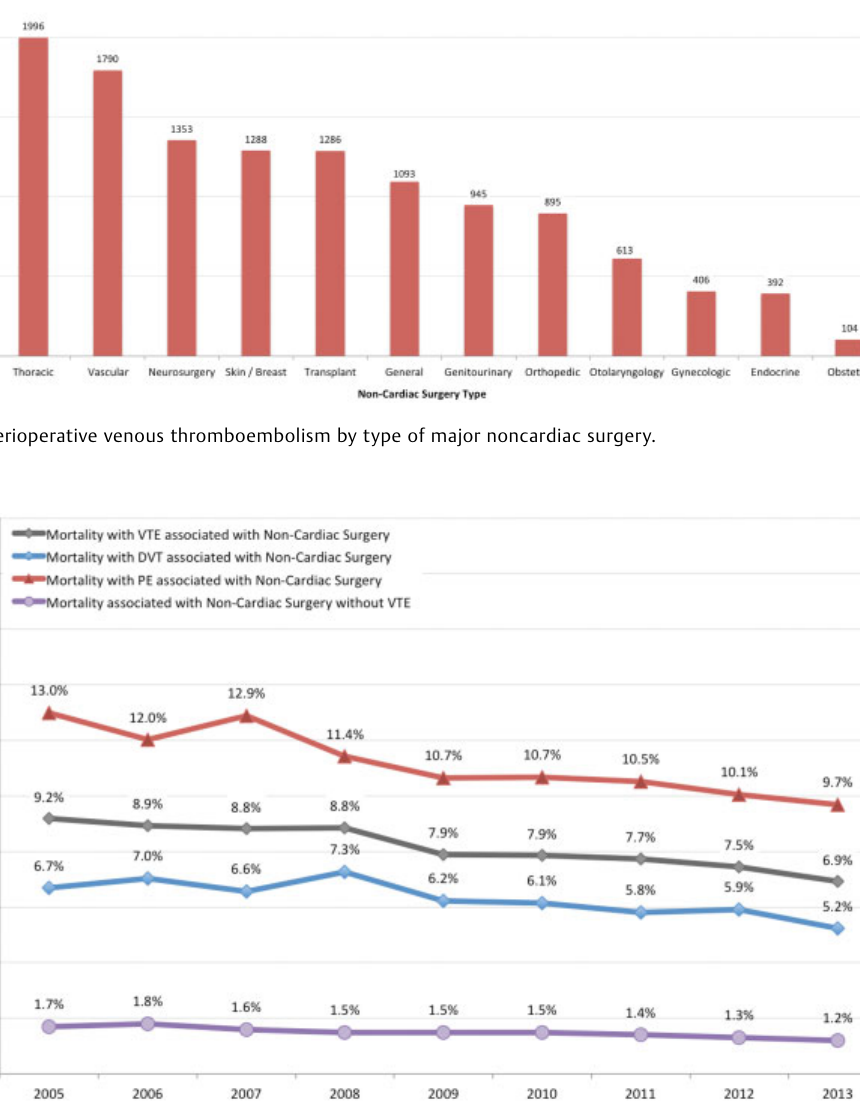
TH Open Vol. 1 No.